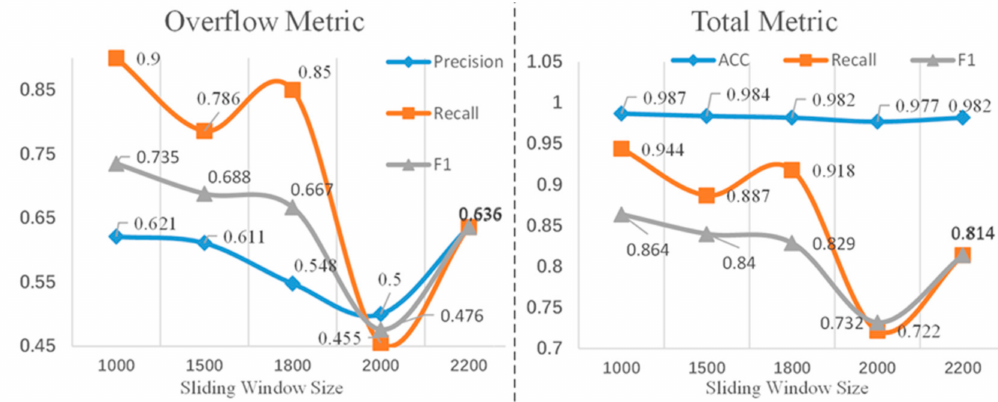
Figure 6. Metrics with different sliding window sizes. Using forecasting + TCN + Transformer in this